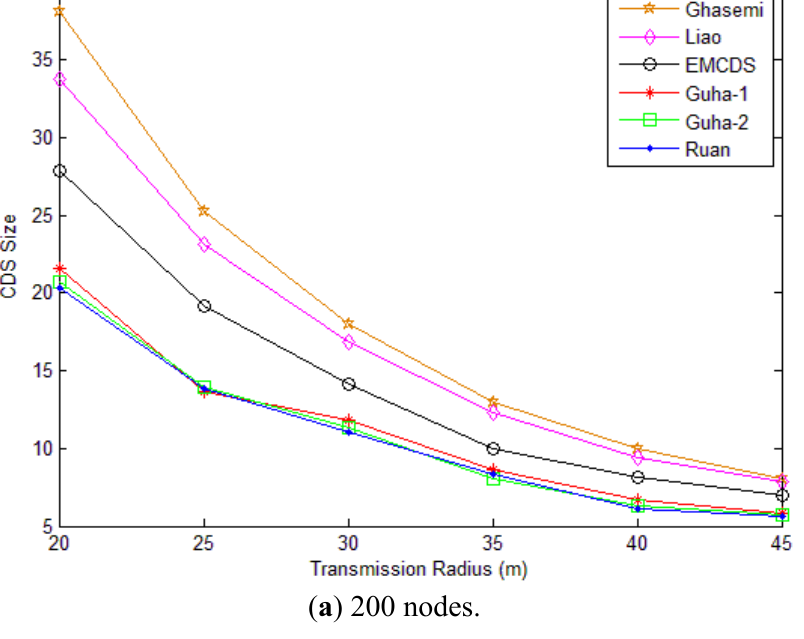
Figure 7. The size of MCDS with different transmission range. ( a ) 200 nodes; ( b ) 1,000 nodes.